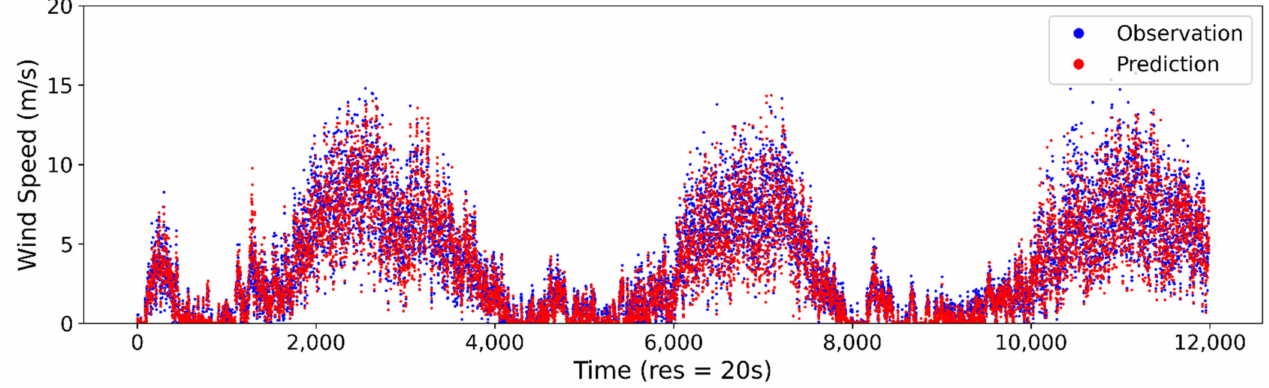
Figure A1. Estimated vs. observed wind speed at 20-s sampling interval using ANN